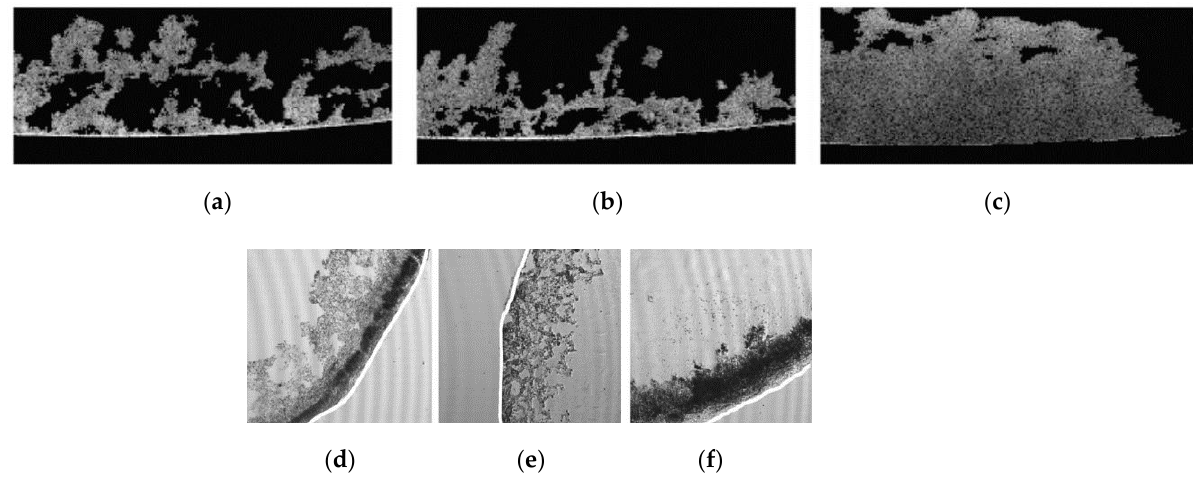
Figure 2. Images of biofilm structures in three flow regimes: ( a ) laminar, ( b ) transient, and ( c ) turbulent by confocal scanning laser microscopy (CLSM), which are more homogeneous in turbulent fluid (reproduced with permission from [27], Copyright John Wiley and Sons, 2010); under three substrate loading rates ( d ) low, ( e ) medium and ( f ) high, by optical coherence tomography (OCT) (reproduced with permission from [24], Copyright Elsevier, 2004), where a low substrate loading leads to low biofilm density [25].